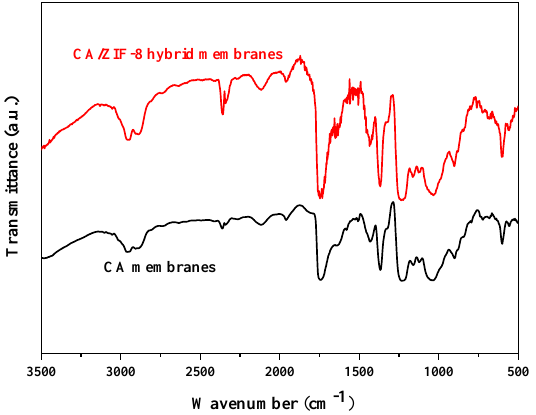
Figure 11. FTIR spectroscopy of CA membrane and CA/ZIF-8 membrane.